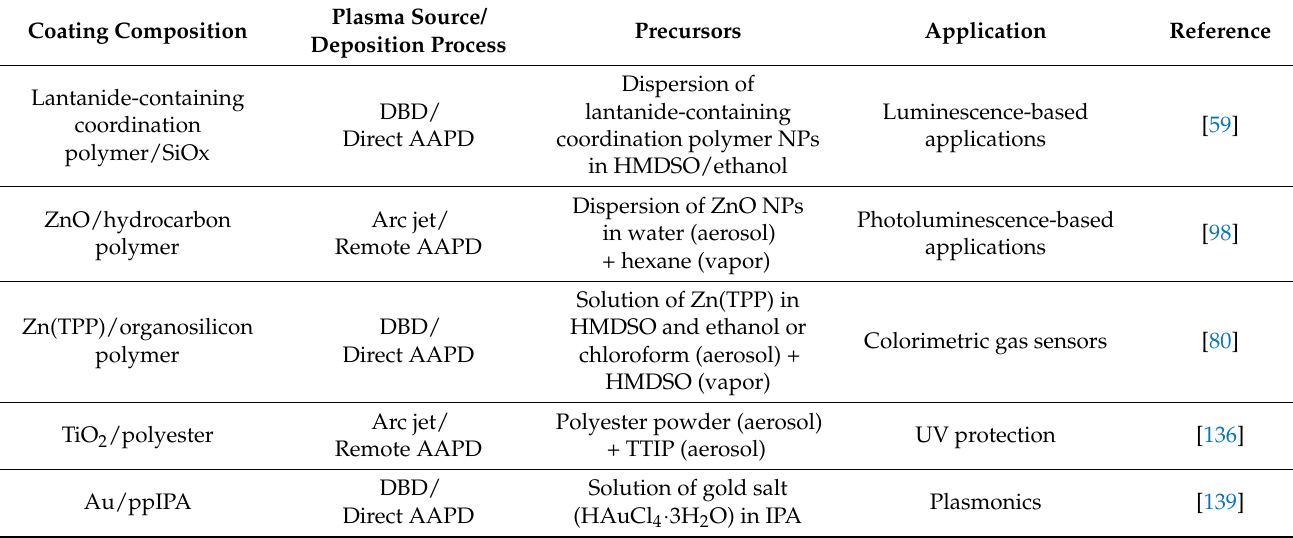
Table 2. Representative studies on APP-deposited NC coatings with specific optical properties. Plasma Coating Composition